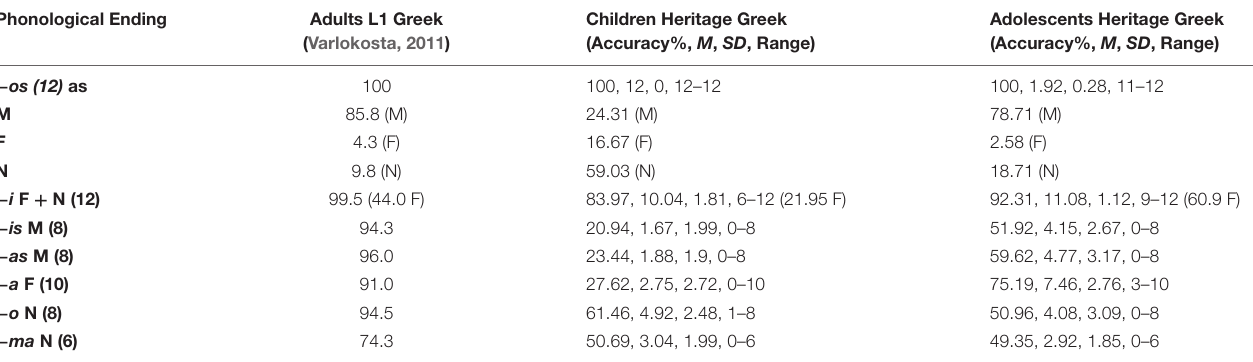
TABLE 3 | Accuracy, mean number, standard deviation, and range of correct responses by child and adolescent Heritage Greek speakers, compared to the accuracy of typical L1 adult speakers as reported by Varlokosta (2011) (novel nouns). Phonological Ending